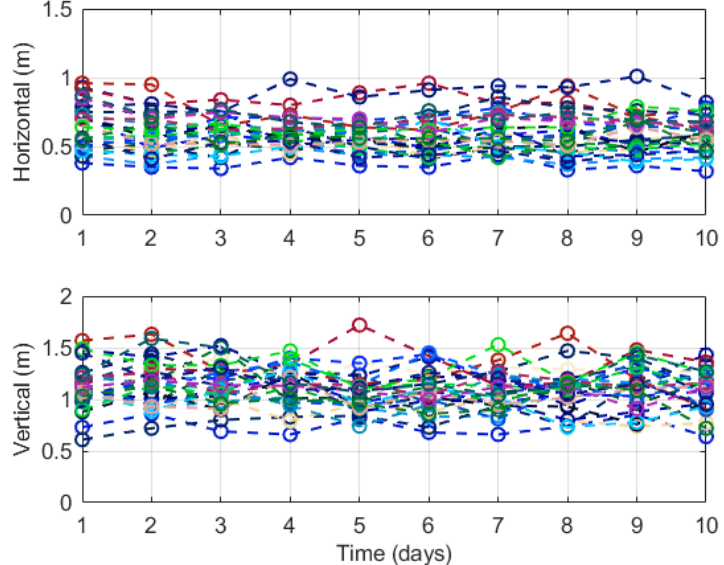
Figure 5. Time series of 95th percentile position errors of 30 monitoring receivers under BDSBAS DFMC service. One color represents one receiver.